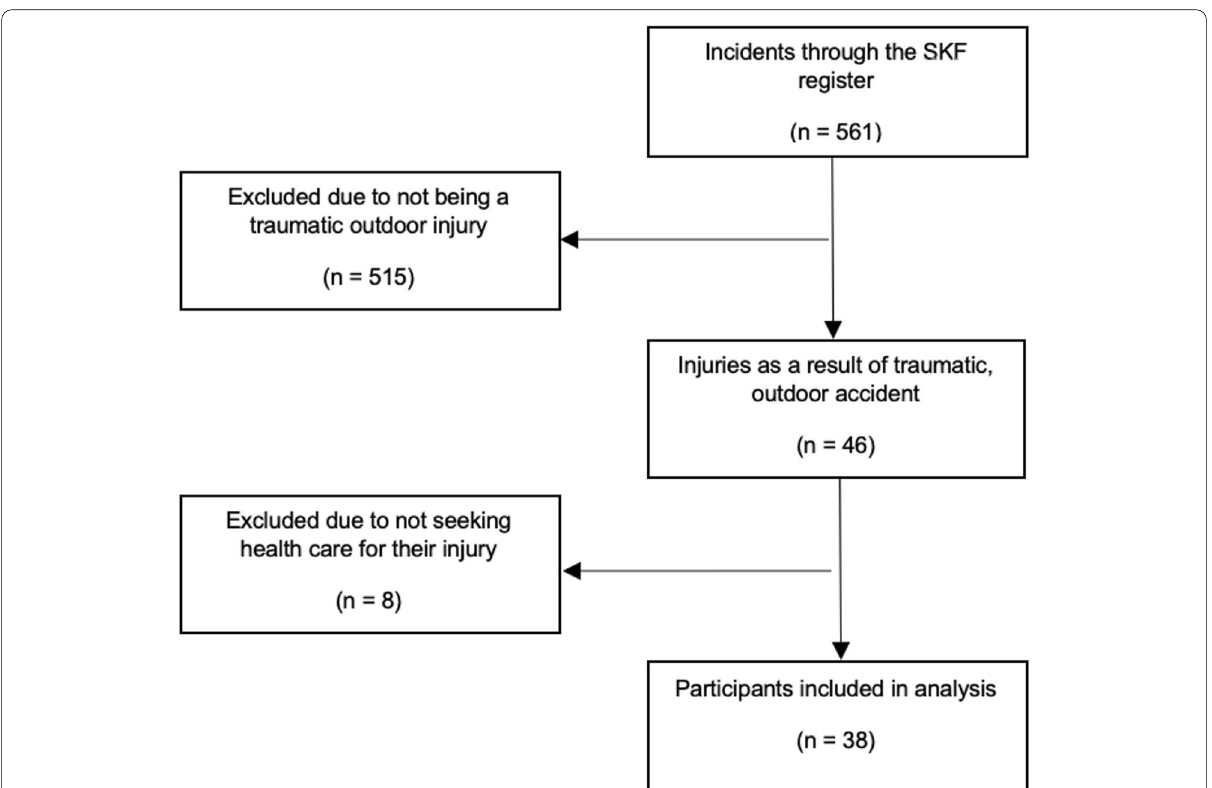
Fig. 1 Flowchart of included